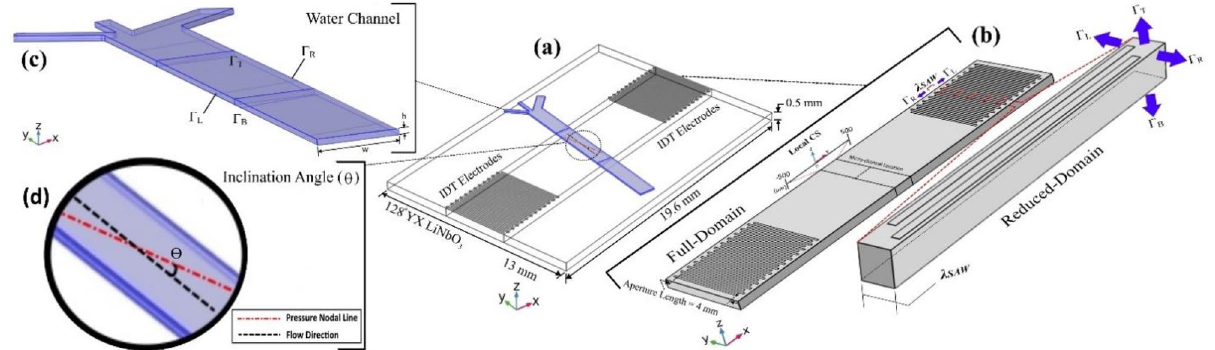
Figure 1. (a) Isometric view from the full 3D model of taSSAW acoustofluidic device, (b) full-domain and reduced-domain 3D model of the substrate, the computational domain boundaries, and considered local CS for substrate polarization, (c) fluid cavity boundaries including Ŵ L , Ŵ R , Ŵ T in contact with PDMS wall, and Ŵ B vibrating boundary in contact with LiNbO 3 substrate, (d) inclination angle ( θ